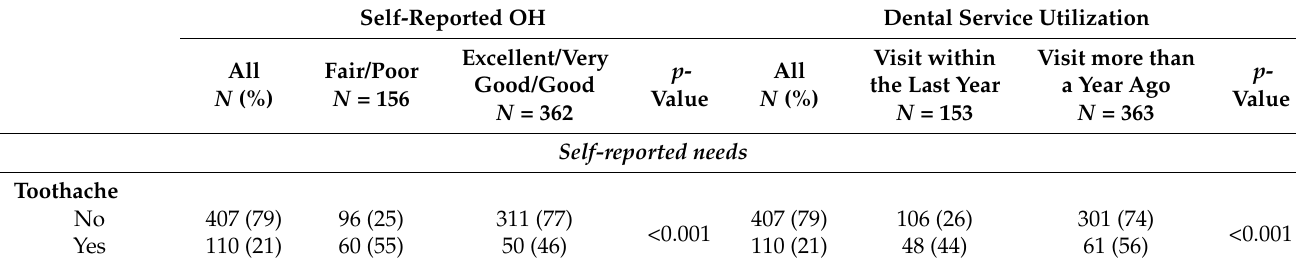
Table 4. Frequency distribution of the Andersen and Newman (A&N) need factors between self-reported oral health and dental